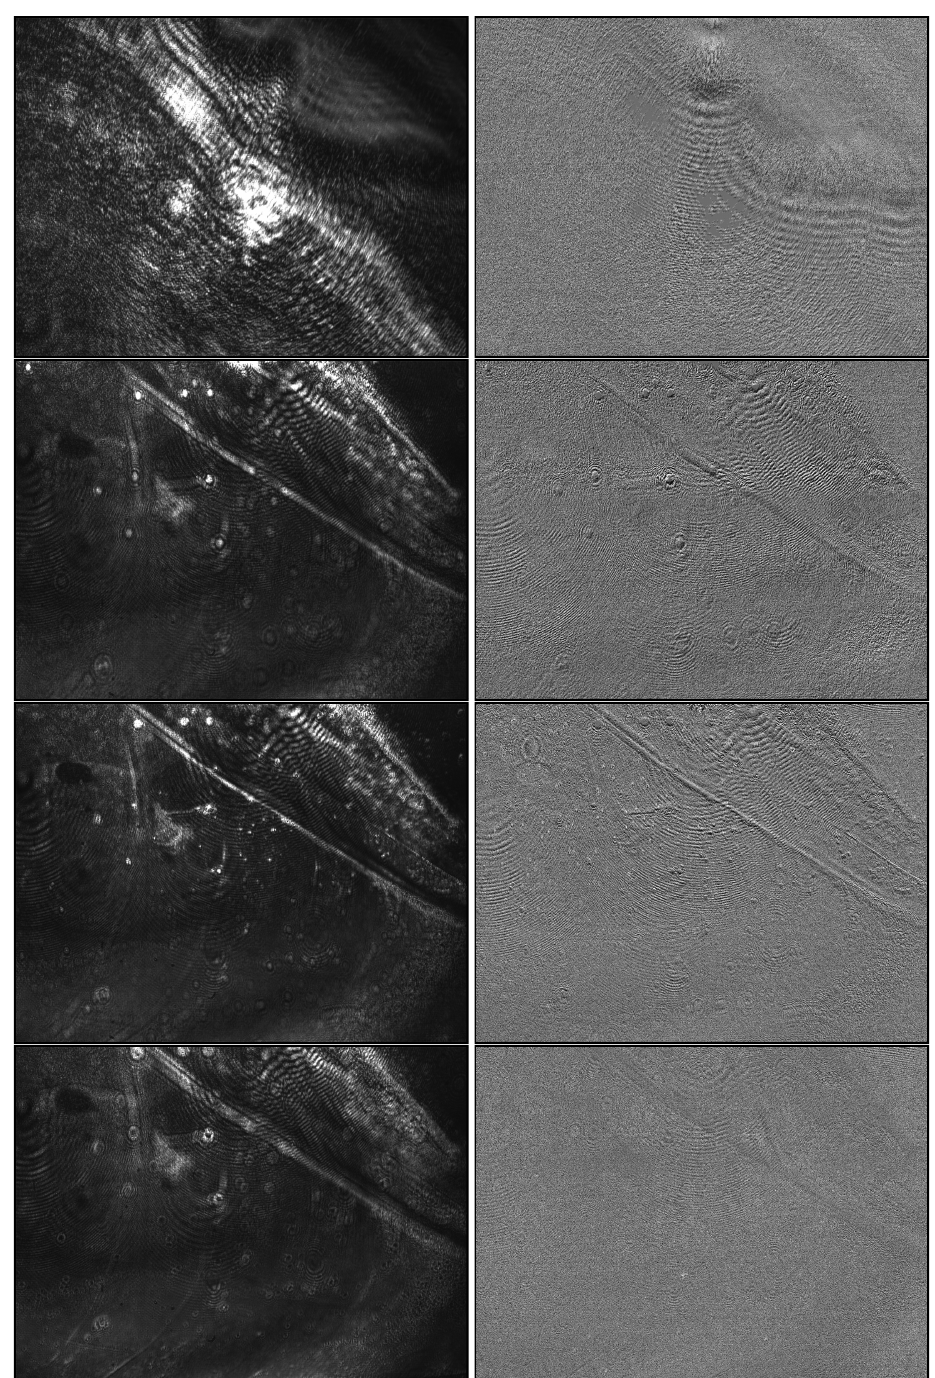
Figure 8. Images recorded at four relative objective positions (0.00, 0.64, 0.68, and 0.72, top to bottom) for a sample containing 300nm polystyrene particles. The left side shows raw images and the right side shows preprocessed images generated in the same positions. The images of position 0.68 contain the focus area, where particle signals can be seen as bright